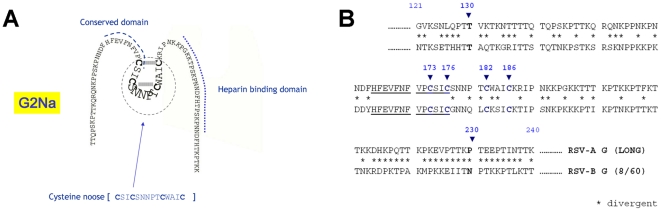
Central conserved domain of RSV G attachment protein (aa130–230).We present here the aa sequence of the conserved domain of (A) G2Na in a hypothetical schematic 2D structure with the highly conserved 13 aa domain followed by the Cysteine noose (dotted circle) [sequence in brackets with Cys res. in bold]. Note the disulphide bridge between the Cys res. and the Lys rich heparin binding domain. (B) G2Na derived from RSV-A (Long) G protein compared to G2Nb derived from RSV-B (8/60) G protein from aa121–240. Conserved domains are underlined. Cys res. positions in bold letters are respectively 173, 176, 182 and 186. (* divergent).